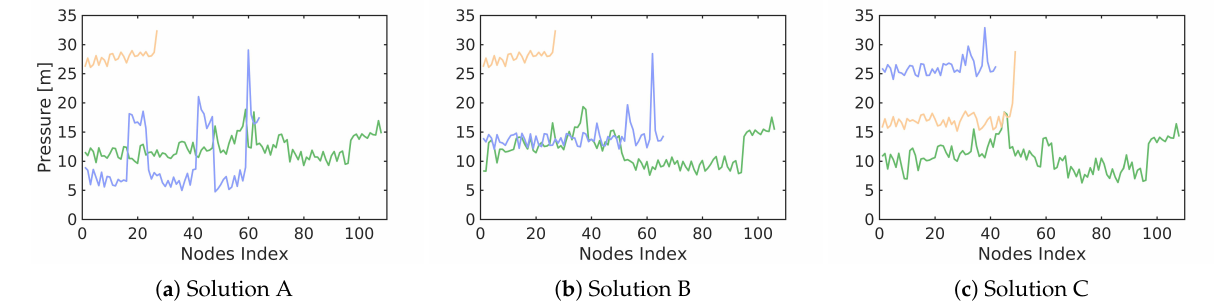
Figure 8. Nodal pressures for the solutions A, B and C for TRN network. Colors code corresponding to DMAs of Figures 6 and